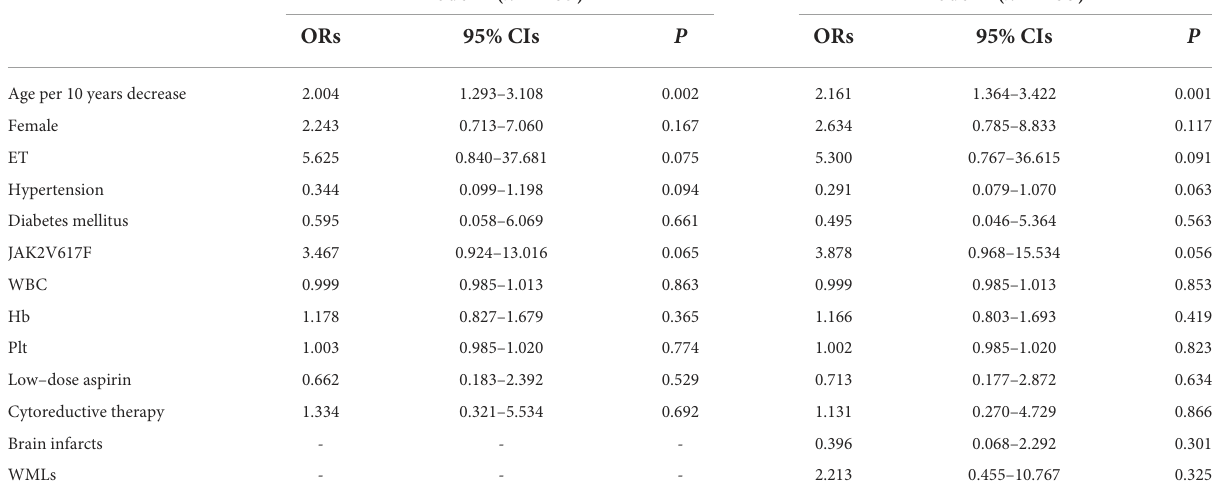
TABLE 3 Multivariate logistic analysis for